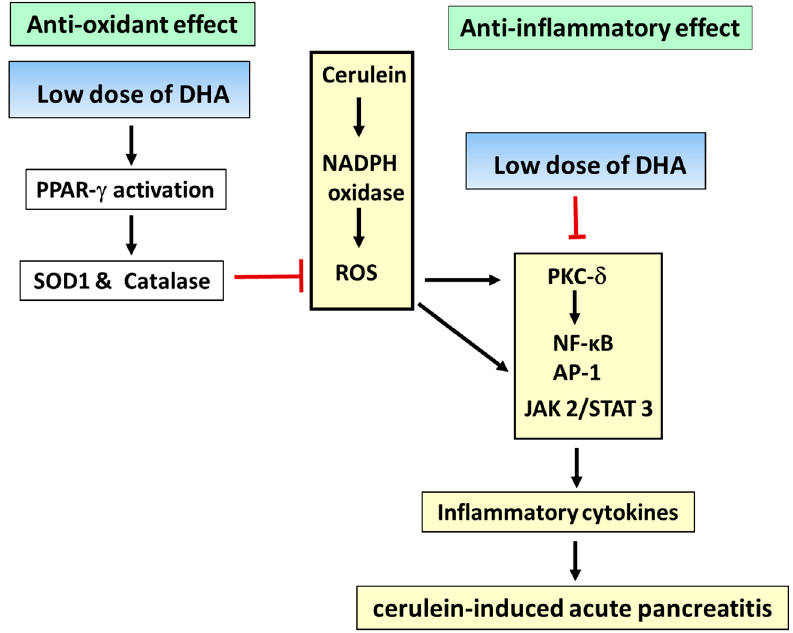
Figure 1. Proposed mechanisms of action of docosahexaenoic acid (DHA) in cerulein-induce acute pancreatitis. Cerulein induced the activation of NADPH oxidase, which produces large amounts of reactive oxygen species (ROS) in pancreatic acinar cells. ROS activate protein kinase C- δ (PKC- δ ), which activates nuclear factor- κ B (NF- κ B). ROS also directly activate NF- κ B, activator protein-1 (AP-1), janus kinase 2 (JAK2)/signal transducer and activator of transcription 3 (STAT3), and inflammatory cytokine expression in the cerulein-stimulated pancreatic acinar cells and rat models. The inflammatory events result in development of acute edematous pancreatitis. DHA induces activation of peroxisome proliferator-activated receptor- γ (PPAR- γ ) and expression of the PPAR γ -target gene, SOD1, and catalase. Since SOD1 and catalase scavenge ROS, DHA inhibits the ROS-mediated activation of inflammatory signaling (PKC- δ , NF- κ B, AP-1, JAK2/STAT3) and inflammatory cytokine expression in cerulein-stimulated pancreatic acinar cells and animal models. Antioxidant and anti-inflammatory effects of DHA may be responsible for preventing the development of acute pancreatitis. The bars represent inhibition, while the arrows represent stimulation.